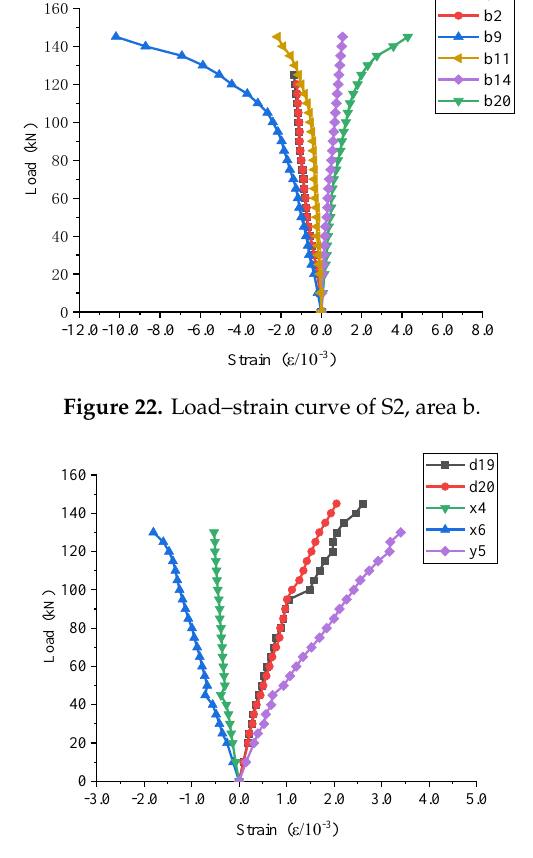
Figure 23. Load–strain curve of S2, areas d, x, y.